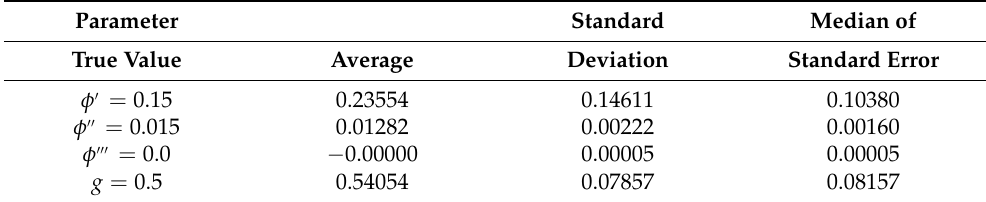
Table 3. Theoretical values of the parameters, averages and standard deviations of estimates across simulations, and averages across simulations of estimated standard errors φ (cid:48) (true value: 0.15), φ (cid:48)(cid:48) (true value: 0.015) and g (true value 0.5) for the tdAR(1) model described above for n = 128 and 999 replications (out of 1000). Parameter Standard Average of True Value Average Deviation Standard